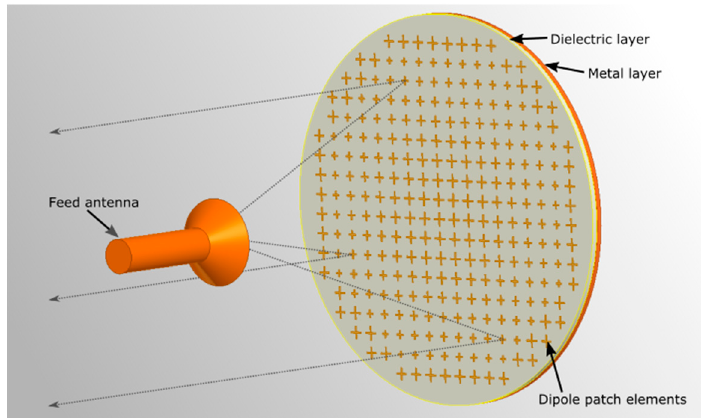
Figure 5. Static backhaul solution based on reflectarray technology.